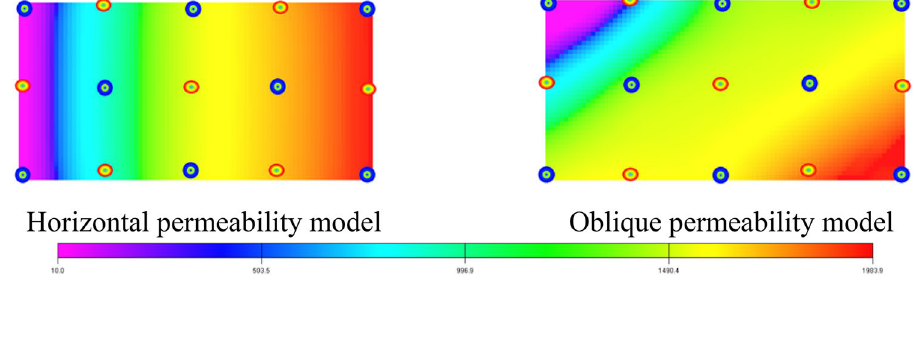
Fig. 7 Schematic diagram of different permeability